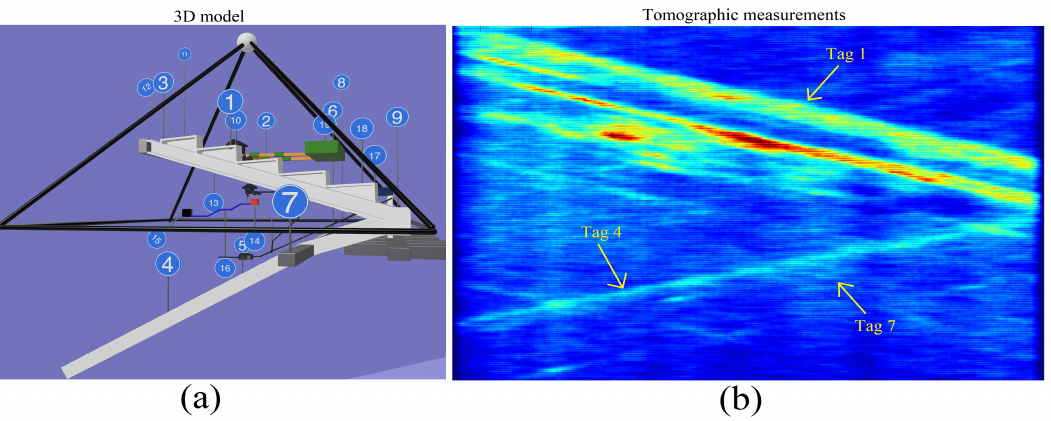
Figure 39. Tags association from tomography to 3D model. ( a ): Three-dimensional (3D) model of Khnum-Khufu (East-side orientation). ( b ): Tomographic reconstruction